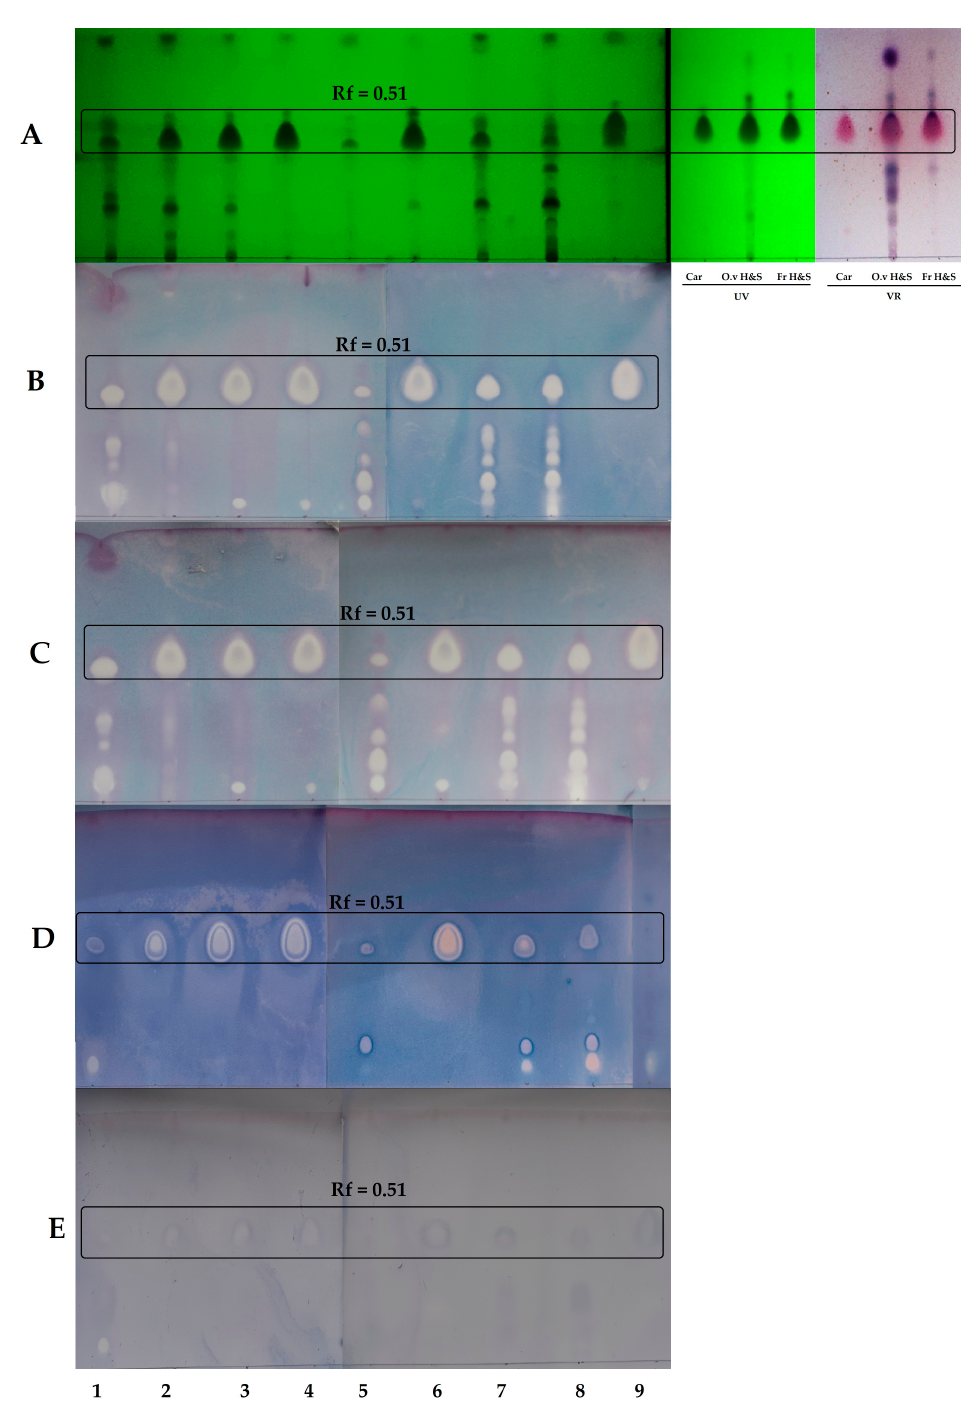
Figure 1. Results of thin-layer chromatography—Direct bioautography; 1 to 9—EOs’ code